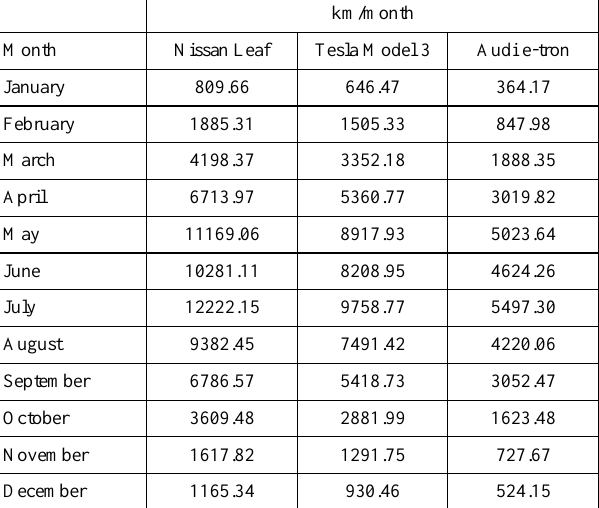
Table 20. Monthly distance provided by PV system for